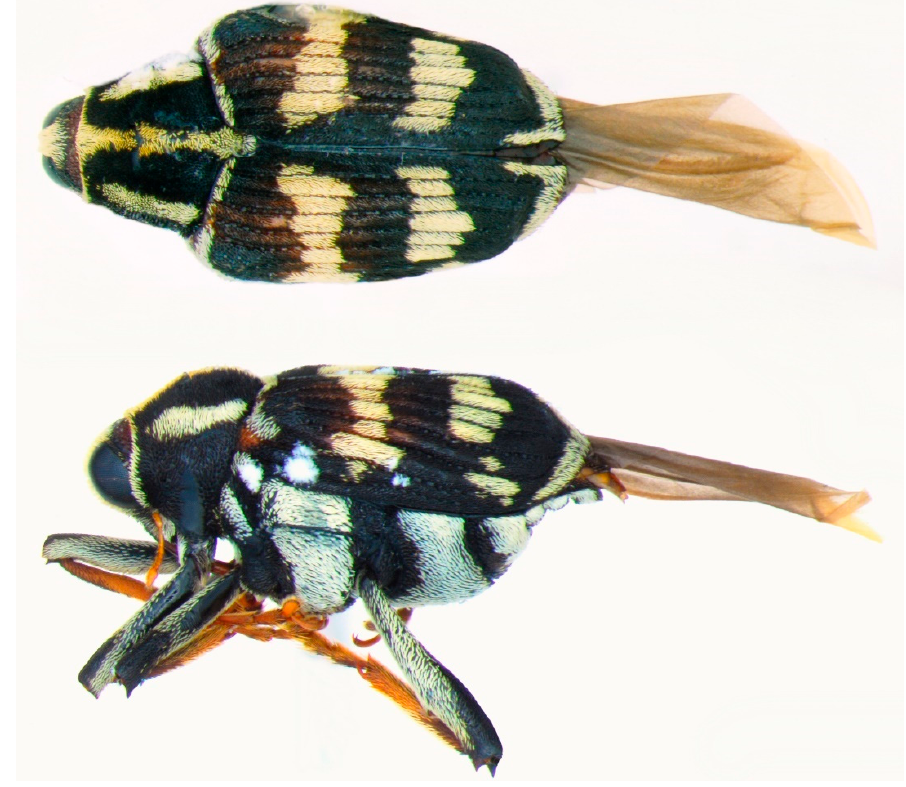
Figure 7. Philenis auritibiae , dorsal and lateral habitus.